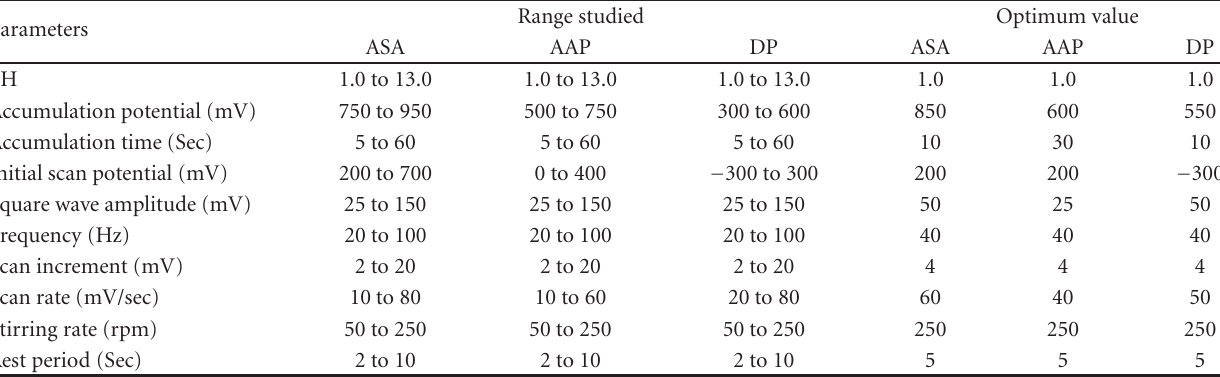
Figure 7: (a) Cyclic voltammogram of DP at pH 1.0 on RF/GCE; scan rate 100mVs − 1 (b) SWSV of DP on RF/GCE under optimum conditions. Table 2: Optimum experimental conditions in SWSV.